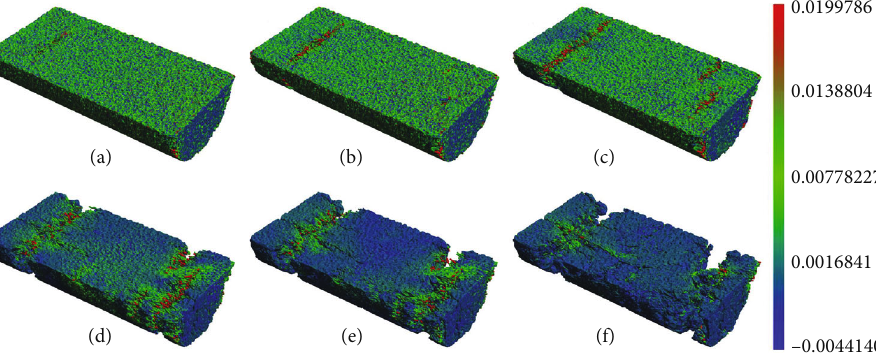
Figure 12: Diagram of the failure process of solid bond elements inside the 0 ° bedding model. The color bar represents the magnitude of the solid bond force